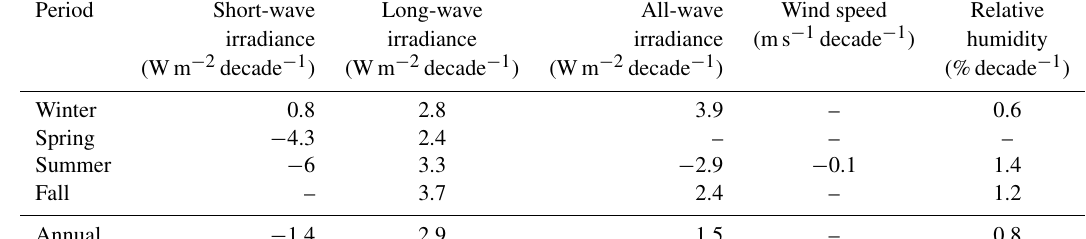
Table 2. Slope for statistically significant weather trends at the p ≤ 0 . 05 significance threshold using the Mann–Kendall test. Period